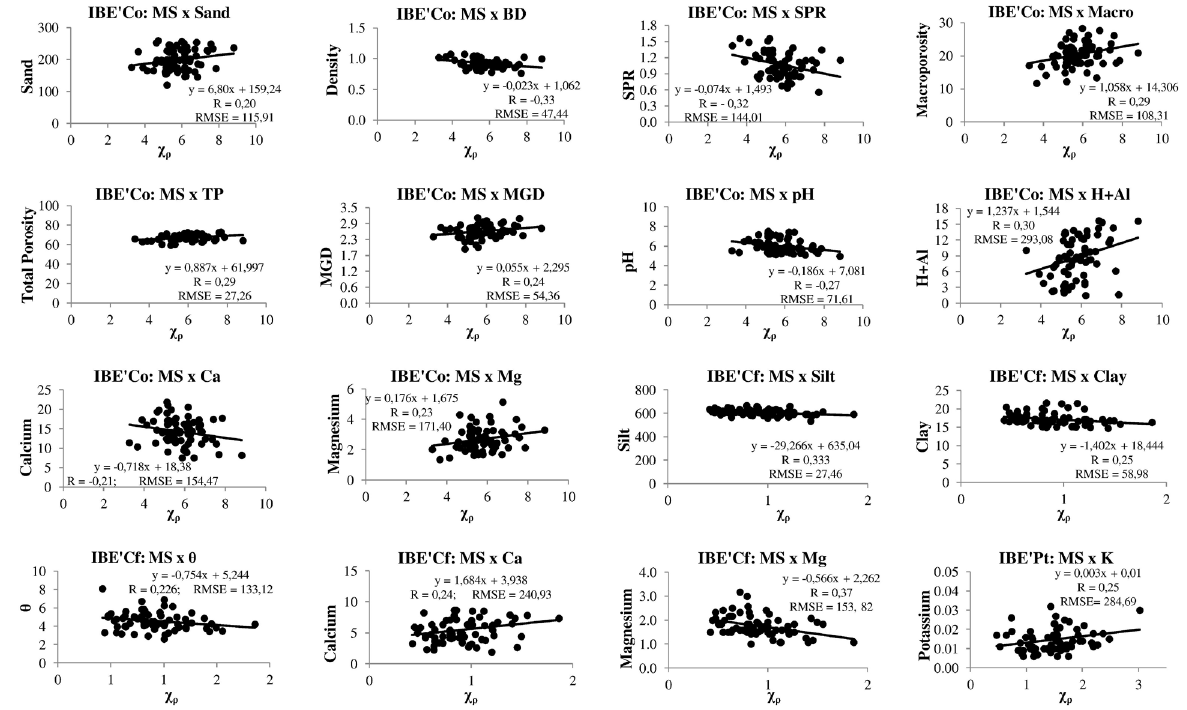
Figure 5. Regression models based on 70 sample points for soil attributes in relation to the mass magnetic susceptibility (analytical balance method) in Indian Black Earth under different crops. IBE’Ca: Indian Black Earth under use with Cocoa; IBE’Cf: Indian Black Earth under use with Coffee; IBE’Pt: Indian Black Earth under pasture